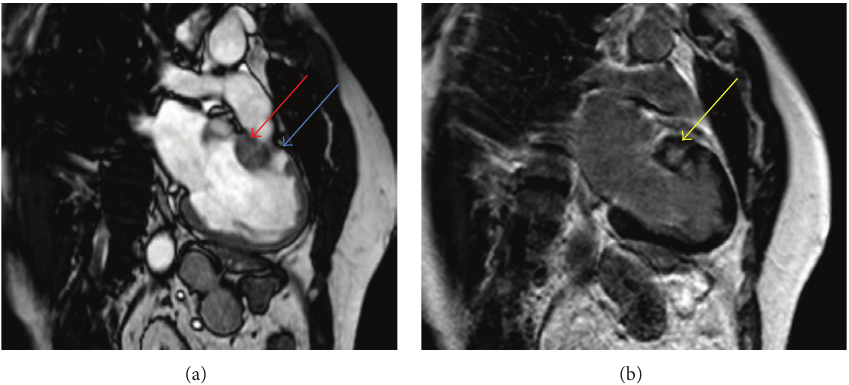
Figure 2: Cardiac magnetic resonance 2-chamber cine view imaging of the patient presented in the case. (a) CMR 2-chamber cine image with the myocardial crypt (blue arrow) in the anteroseptal segment on the left and hypertrophy (red arrow) of the basal interventricular septum. (b) CMR 2-chamber image delayed enhancement with mid wall fibrosis in the basal anterior segment (yellow arrow).